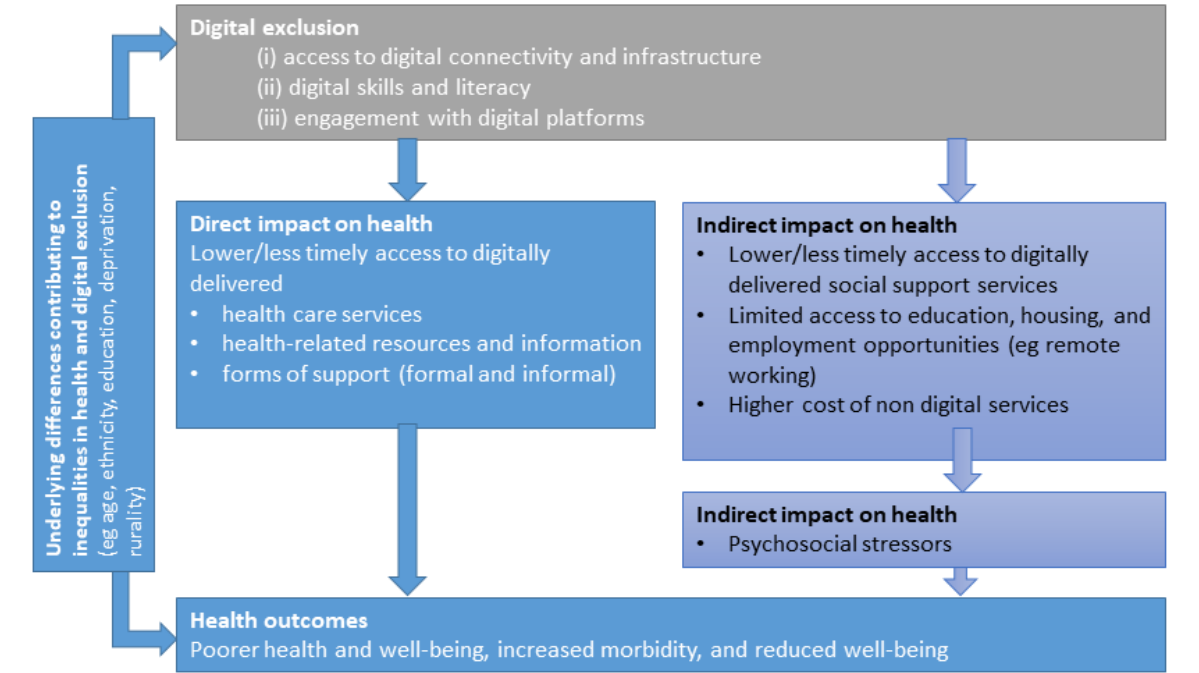
Figure 1. The direct and indirect impacts of digital exclusion on health inequalities. Adapted from McAuley